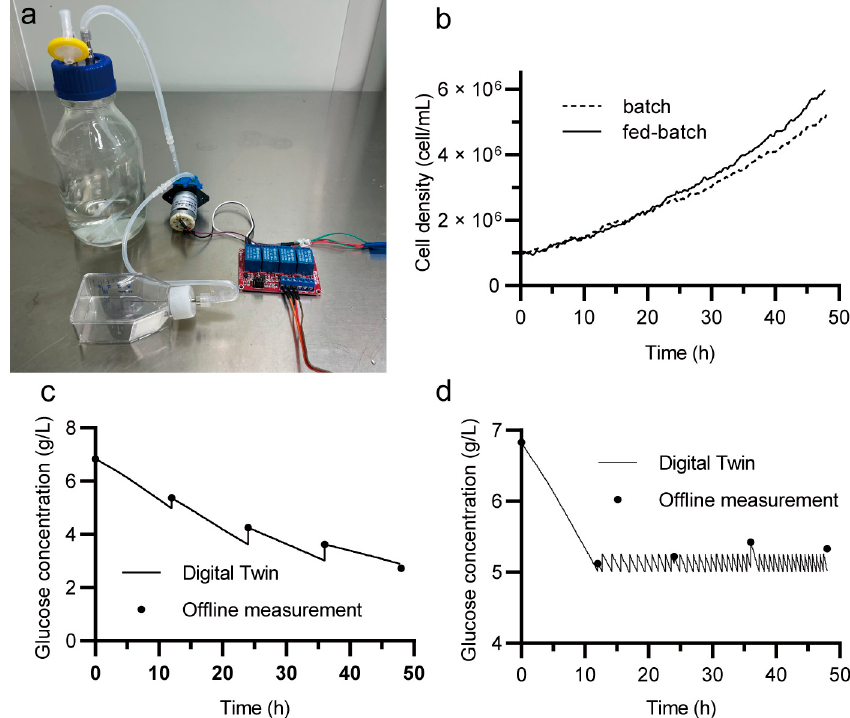
Figure 7. ( a ) Components and connections of the automated feeding system. ( b ) Cell densities in the batch and batch-fed cultures. ( c ) Evolution of the glucose concentration in the batch culture. ( d ) Changes of glucose concentration in the automated fed-batch culture.